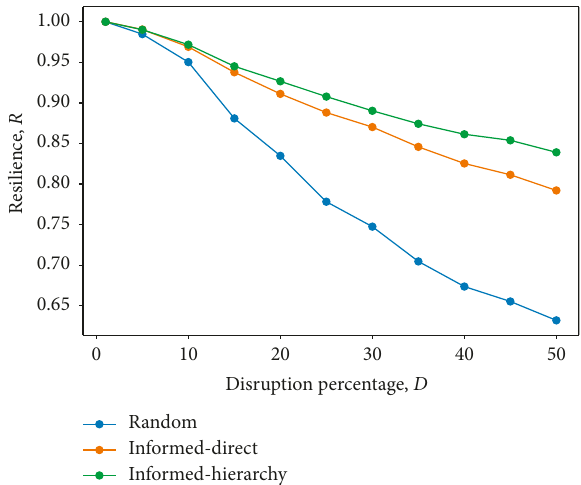
Figure 7: Resilience curve of random (blue) and informed recovery strategies (orange � direct mode and green � hierarchy mode). The gap between the resilience value of the hierarchical and direct reporting mode is getting wider along with the increasing of disruption percentage D , indicating the better performance of the hierarchical reporting mode during major disruptions.